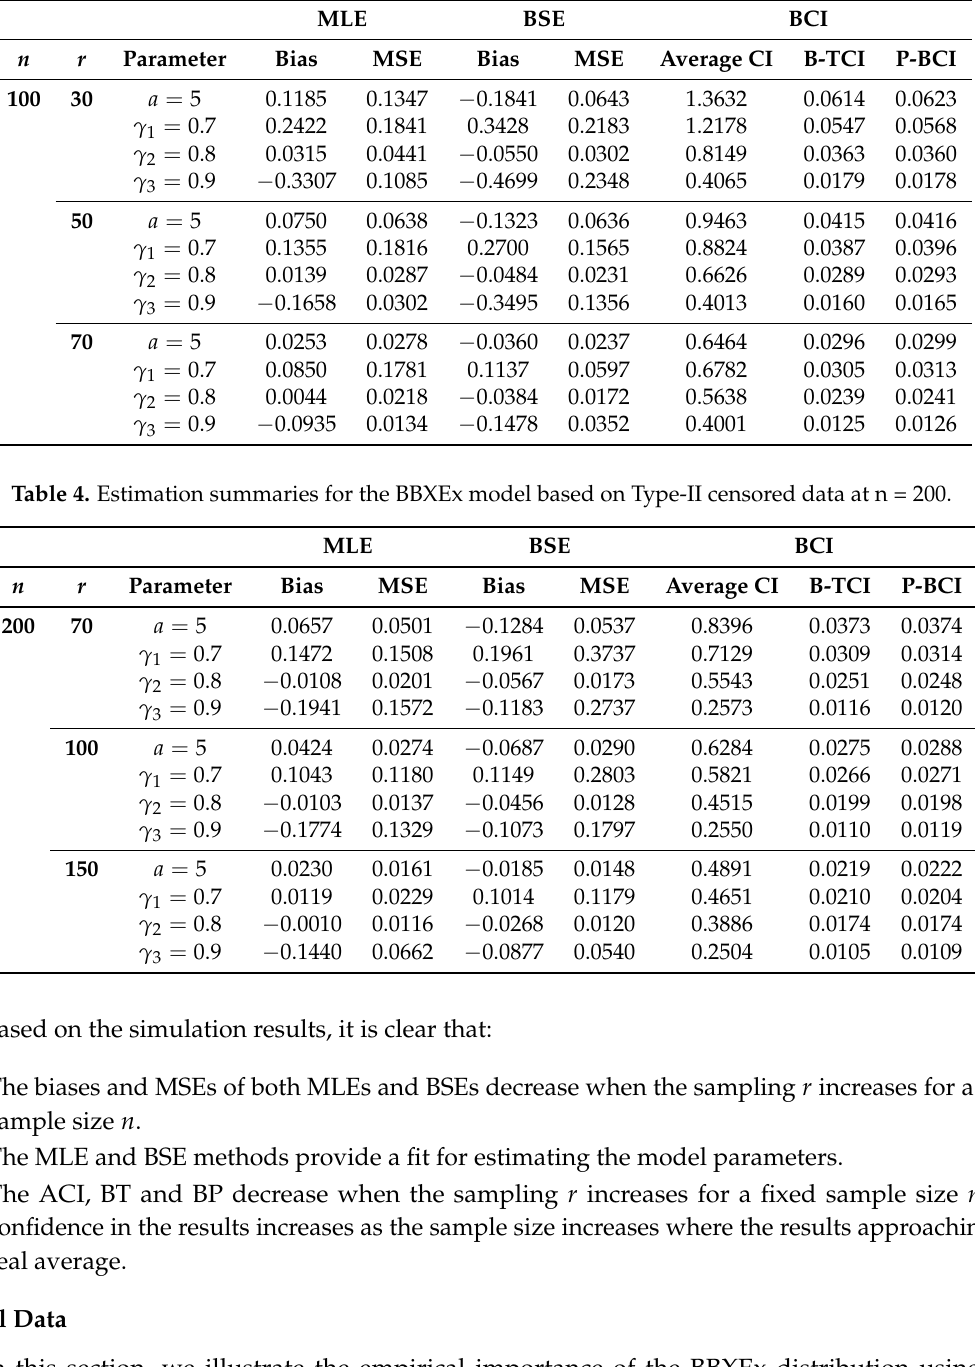
Table 3. Estimation summaries for the BBXEx model based on Type-II censored data at n = 100.